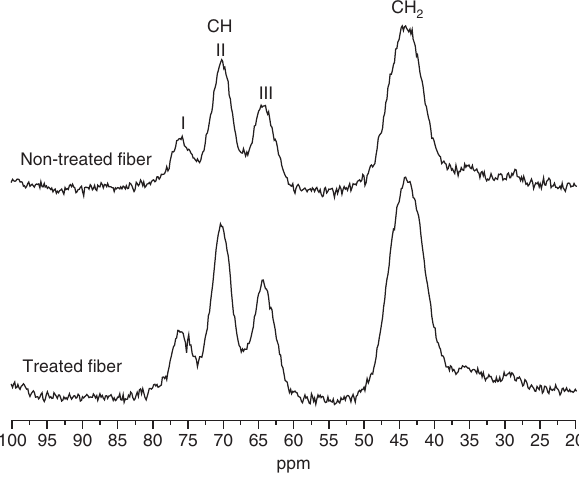
Figure 4: CP/MAS 13 C NMR spectra of untreated and treated PVA fibers.